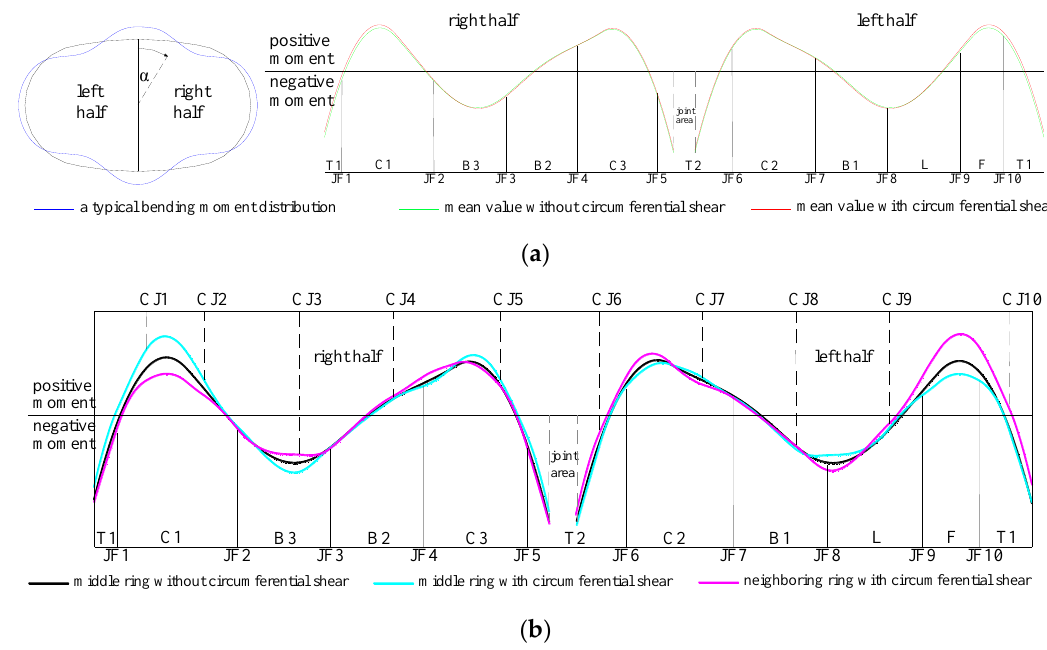
Figure 14. Comparison of bending moment distribution: ( a ) a typical bending moment distribution and mean bending moment values with and without circumferential shear; ( b ) bending moment distribution in different rings.